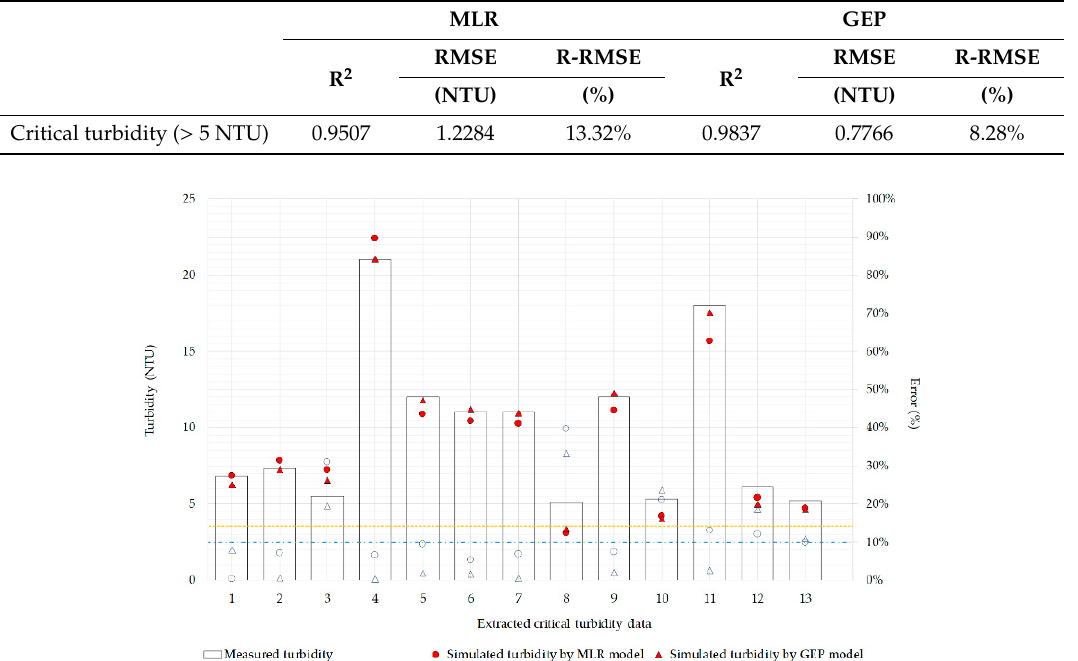
Figure 14. The simulation error of the multiple linear regression (MLR) and the gene-expression programming (GEP) model in the critical turbidity condition.